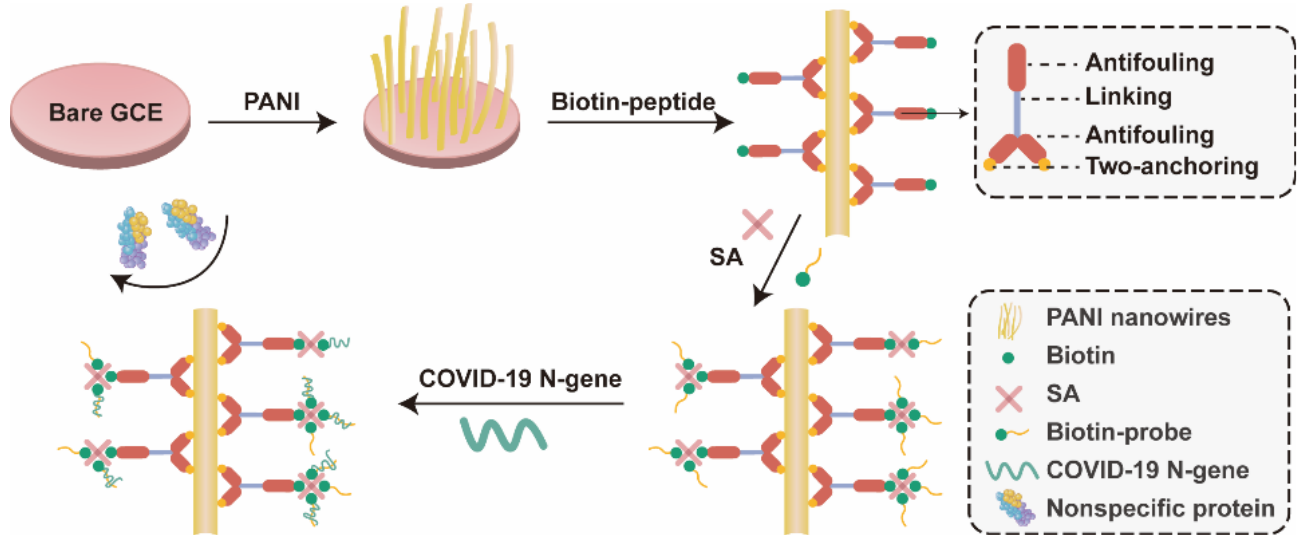
Figure 11. Schematic representation of the antifouling COVID-19 sensor. PANI, polyaniline; SA, streptavidin; GCE, glassy carbon electrode. Adapted from Ref. [155] with permission from the American Chemical Society. © 2021, American Chemical Society.